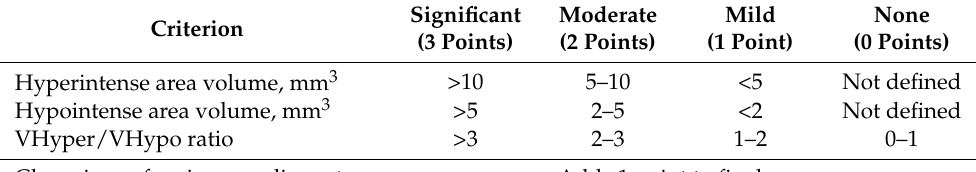
Table 1. Visual assessment scoring of severity of spinal cord injury according to MRI data.